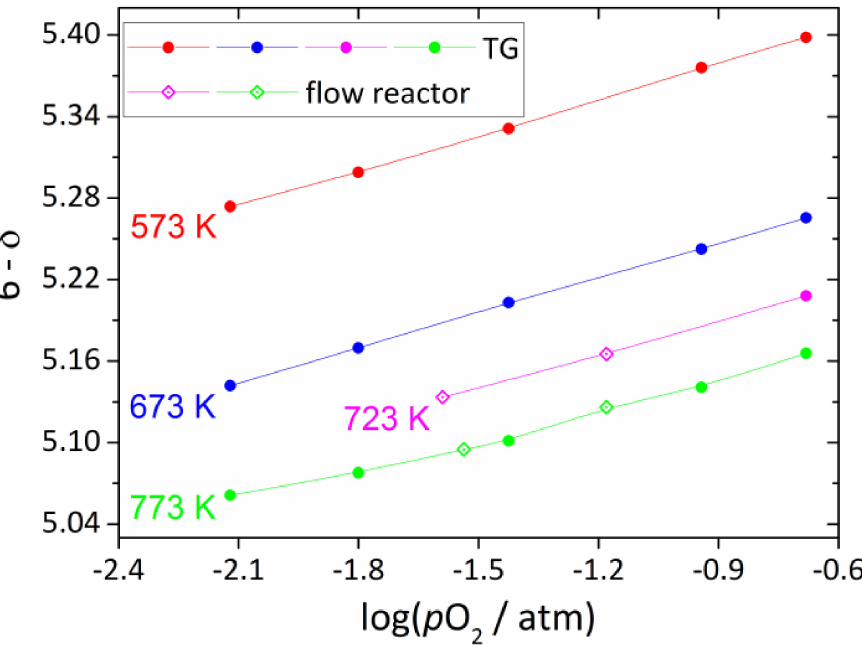
Figure 4. Oxygen content in YBC as function of T and p O 2 . Solid lines are guides to the eye only. The combined p O 2 - T - δ -dataset including both the data obtained by us previously [29,30] and those measured in the present work was used to analyze the defect structure of YBC. The same defect structure model as used before [29] was employed. The defect reactions considered within the framework of this model are given in Table